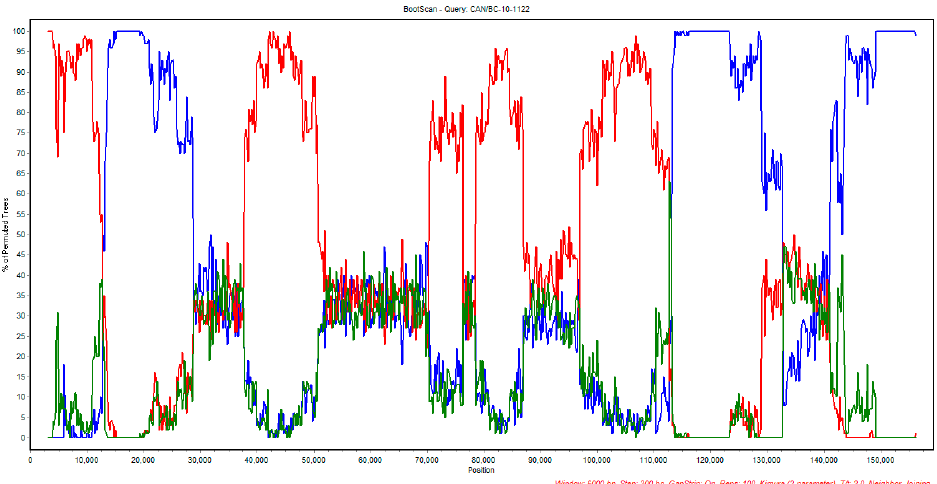
Figure 3. Bootscan analysis plot of CAN/BC-10-1122 with the suggested parental vaccine strain TCO LT-IVAX ® (red) and Poulvac ILT ® strain (blue). US 1874C5 strain was used as control (green).